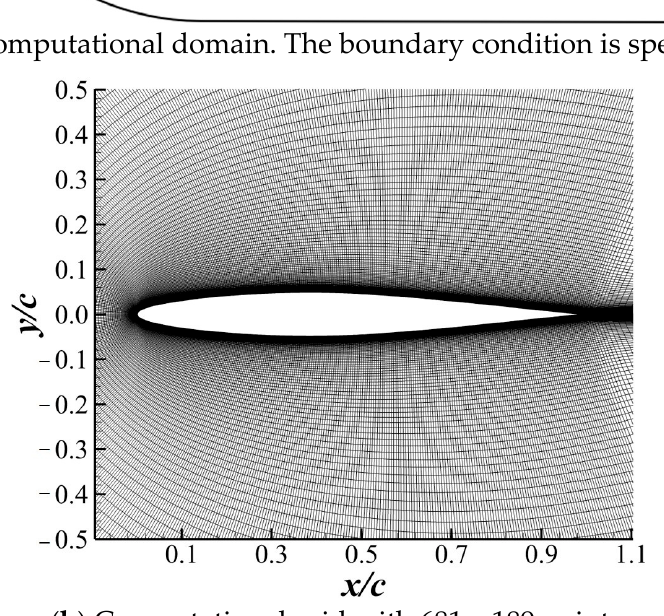
( c ) Grid convergence study. Figure 2. (a) The schematic diagram of the computational domain with boundary conditions, where 𝑟 is the radius of the outer boundary in front of the airfoil, 𝑑 (cid:2869) is the distance between the trailing